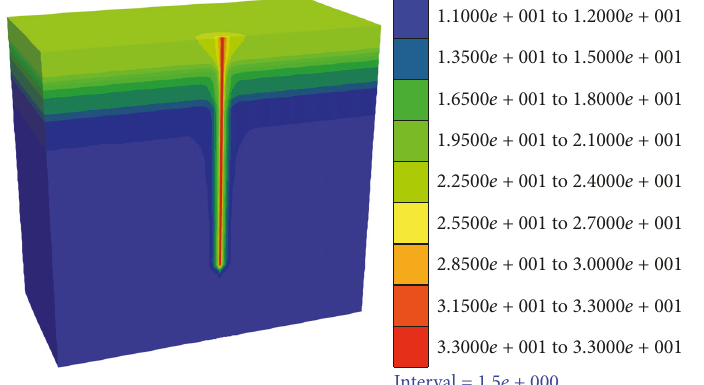
Figure 12: Thermal diffusion contour of energy pile in